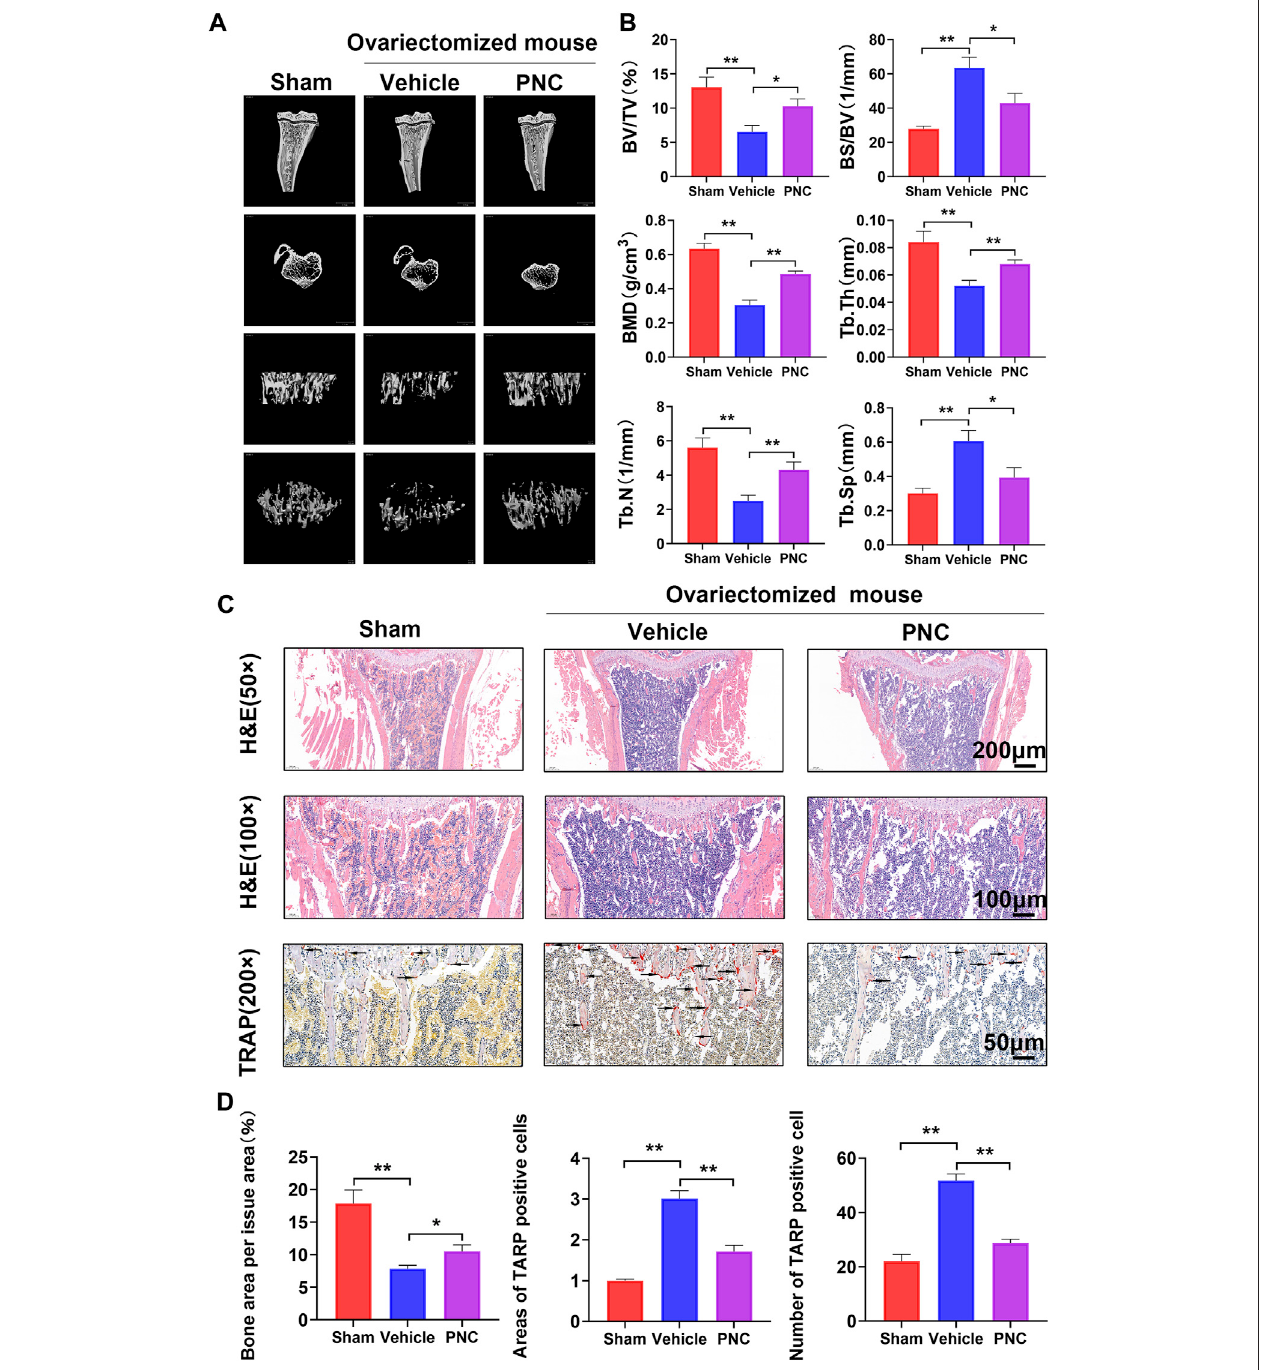
FIGURE4| PNCattenuatedboneresorptionandsuppressedosteoclastactivationfromtheOVXmice. (A) High-resolutionmicro-CTscanningoftibiainOVXmice. Severetibialtrabecular destructionandboneresorptionofthevehicle-treated micecompared tothePNC-treatedOVXmice. (B) BS/BV,BV/TV,Tb.Th,Tb.N, BMD,and Tb.Sp of each tibia sample were determined as indicated in the methods ( n (cid:1) 5). (C) H&E and TRAP staining of tibial slices of the OVX mice (the black arrows of TRAP staining indicate TRAP-positive osteoclasts). (D) Area as well as number of TRAP-positive osteoclasts and bone area per tissue area were determined by ImageJ software. ( n (cid:1) 5). PNC (cid:1) (5 mg/kg/day). ** p < 0.05, ** p < 0.01 versus the vehicle group.